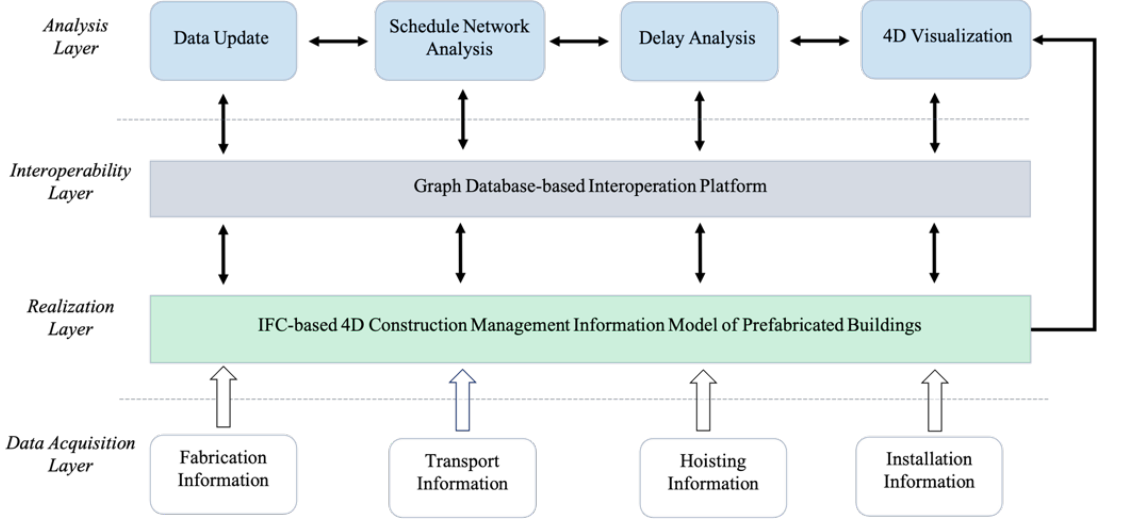
Figure 1. Framework overview.